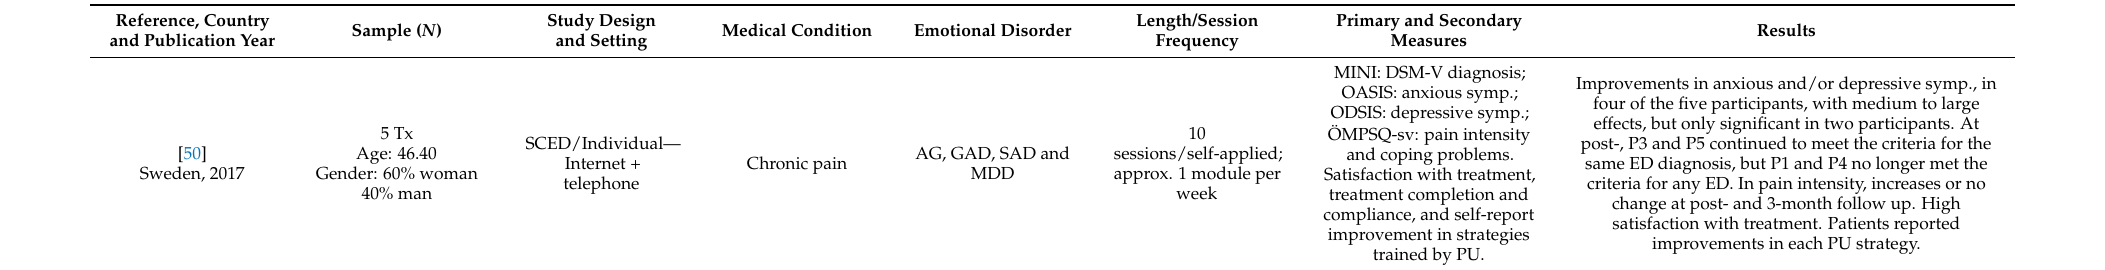
Table 3. Characteristics of the included research